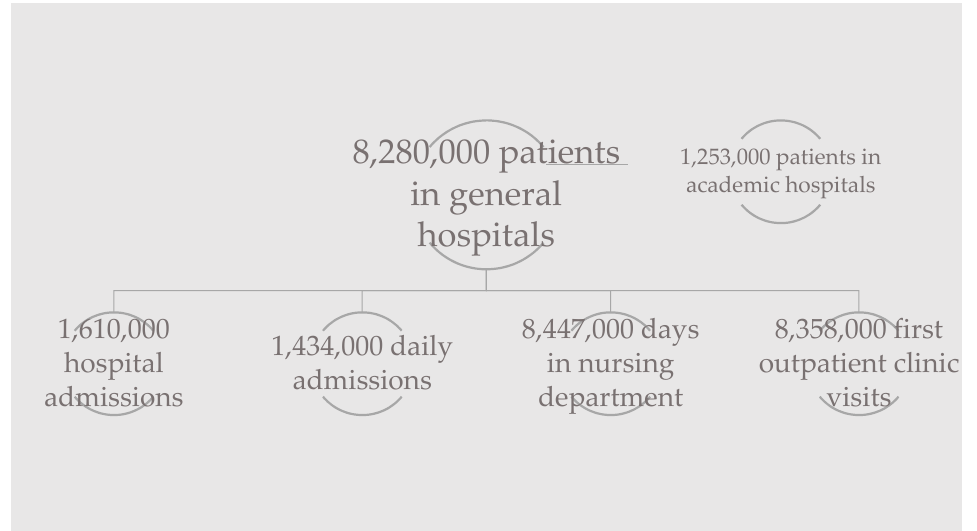
Figure 8. Overview of visitor numbers in Dutch hospitals in 2017 [20,22,23].